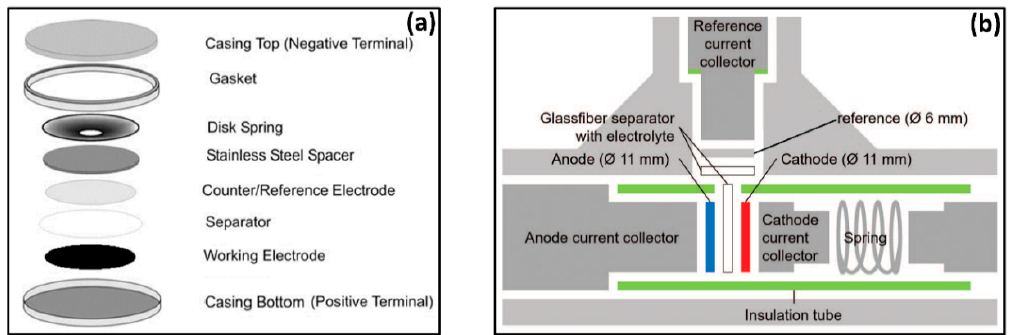
Figure 11. Schematic representation of a two ‐ electrode coin cell ( a ) and three ‐ electrode T ‐ shape Swagelok cell ( b ). Figure adapted with permission from [73,107].